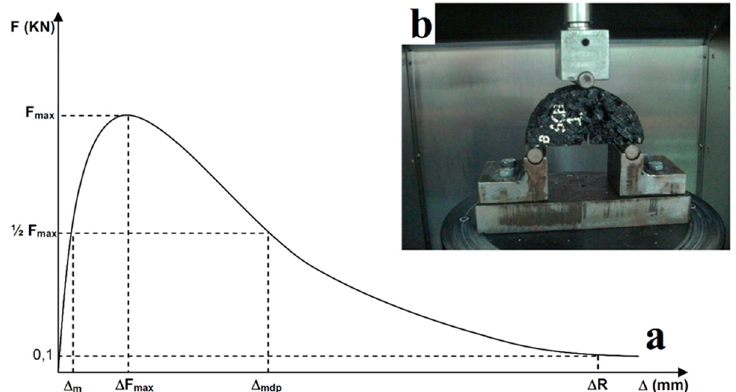
Figure 4. ( a ) Load–displacement curve and ( b ) sample used in the test SCB. W D = the work done